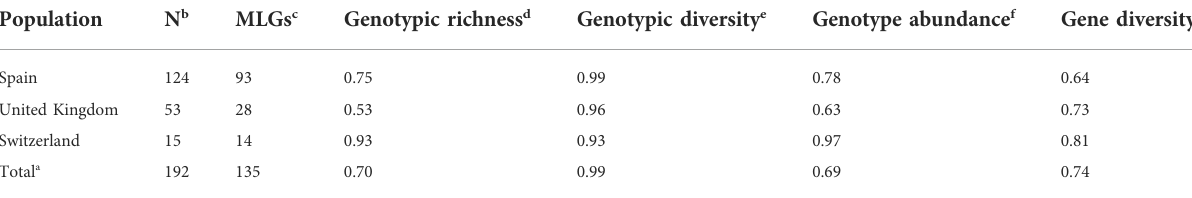
TABLE 2 Genetic diversity parameters of sexually-derived Puccinia graminis isolates from three European populations at 19 microsatellite loci. Population